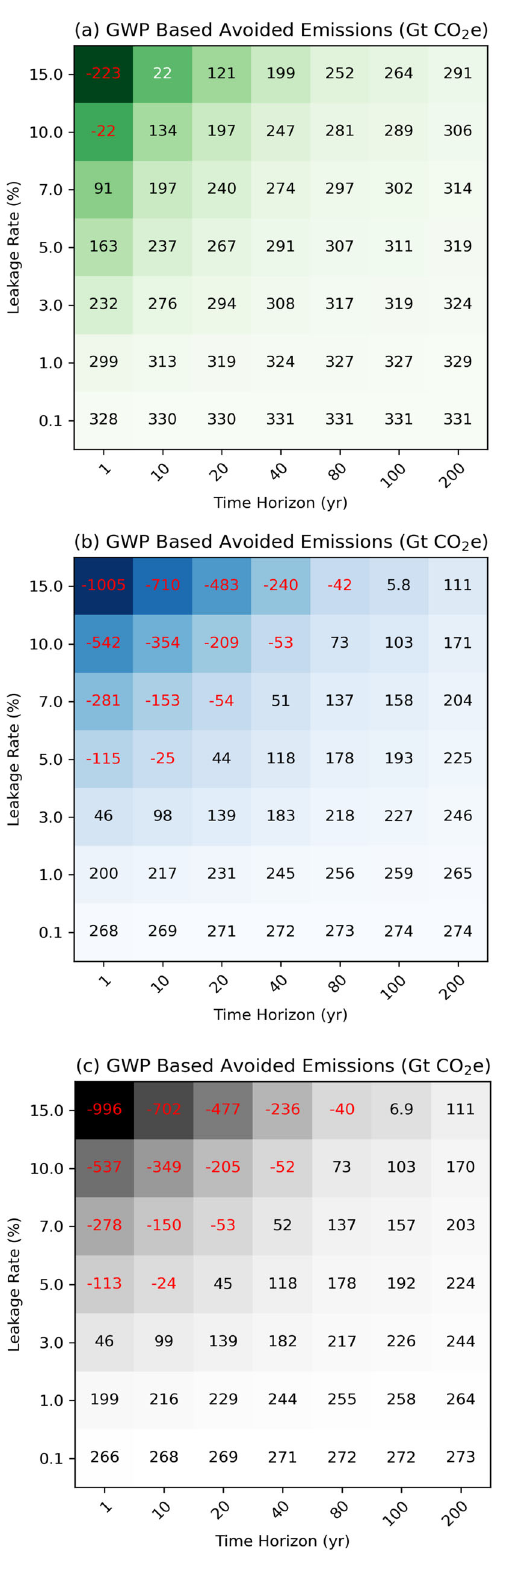
hydrogen metrics (i.e., GWP in Fig. 5 and CGTP in Fig. 6) calculated based on the hydrogen northern hemisphere lifetime (see Table 1). Figure 5 shows the cumulative CO 2 emissions abatement calculated based on the GWP as a function of the leakage rate and time-horizon. In the case of a green hydrogen supply (Fig. 5a), the cumulative CO 2 abatement accounting for